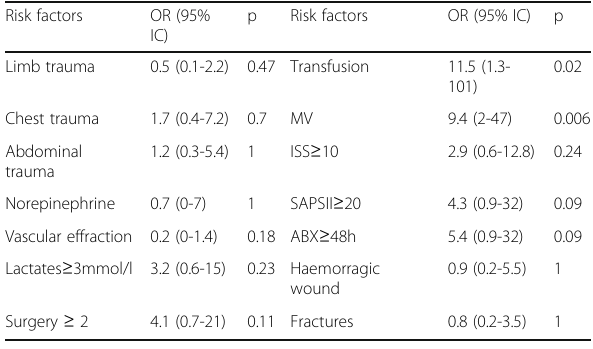
Table 1 (abstract 0014). Risk factors of GWT infections (univariate analysis) Risk factors OR (95%